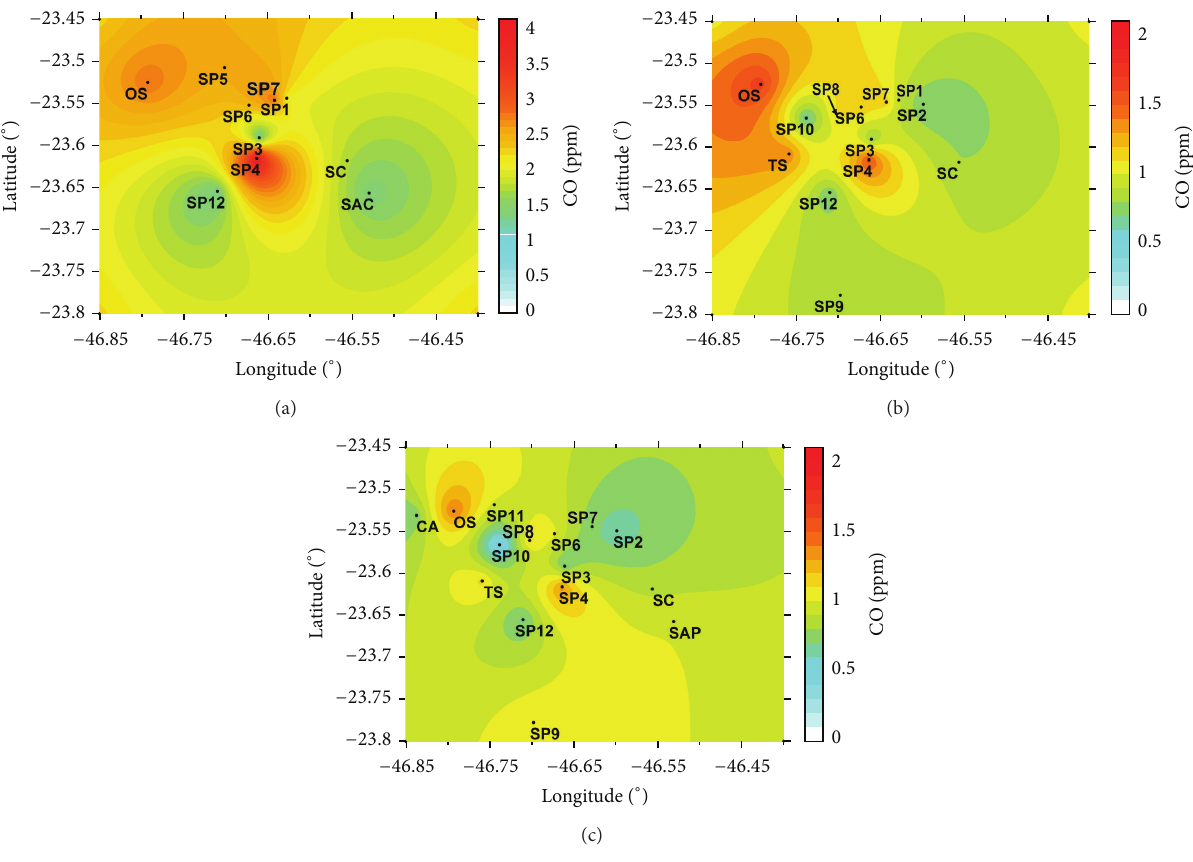
Figure 5: Spatial distribution of the annual average of CO concentration during (a) 1997, (b) 2008, and (c) 2012. CO concentration is in ppm. Contour interval is 0.2 ppm. Obs.: Color scale is different between (a) and (b, c).